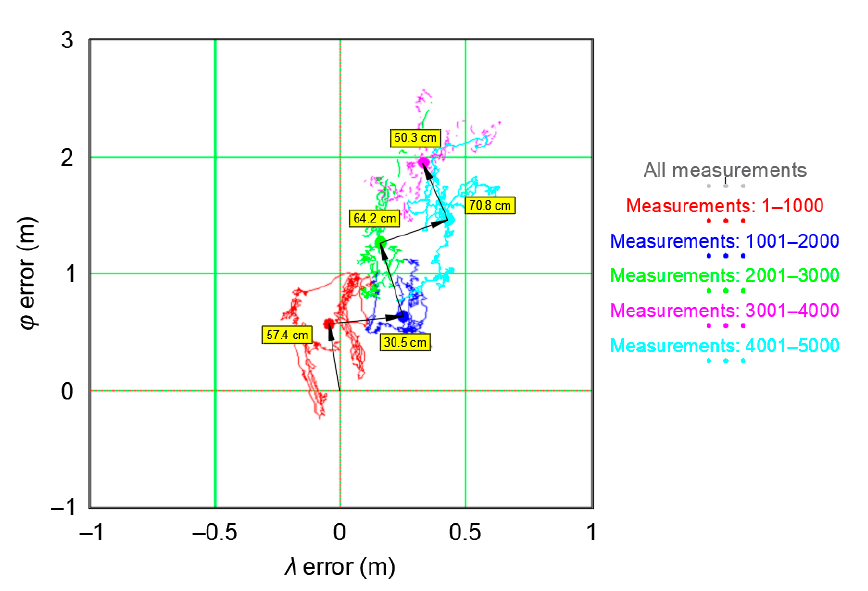
Figure 8. Distances between the mean coordinates P ( S N ) calculated for five GPS sessions during the measurement campaign in 2013.